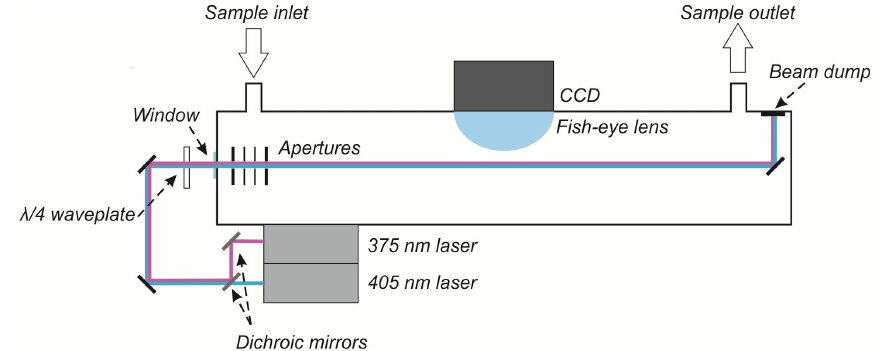
Figure 1. Laser imaging nephelometer instrument diagram showing beam paths of the 375 and 405nm beams, which are cycled in sequence in the